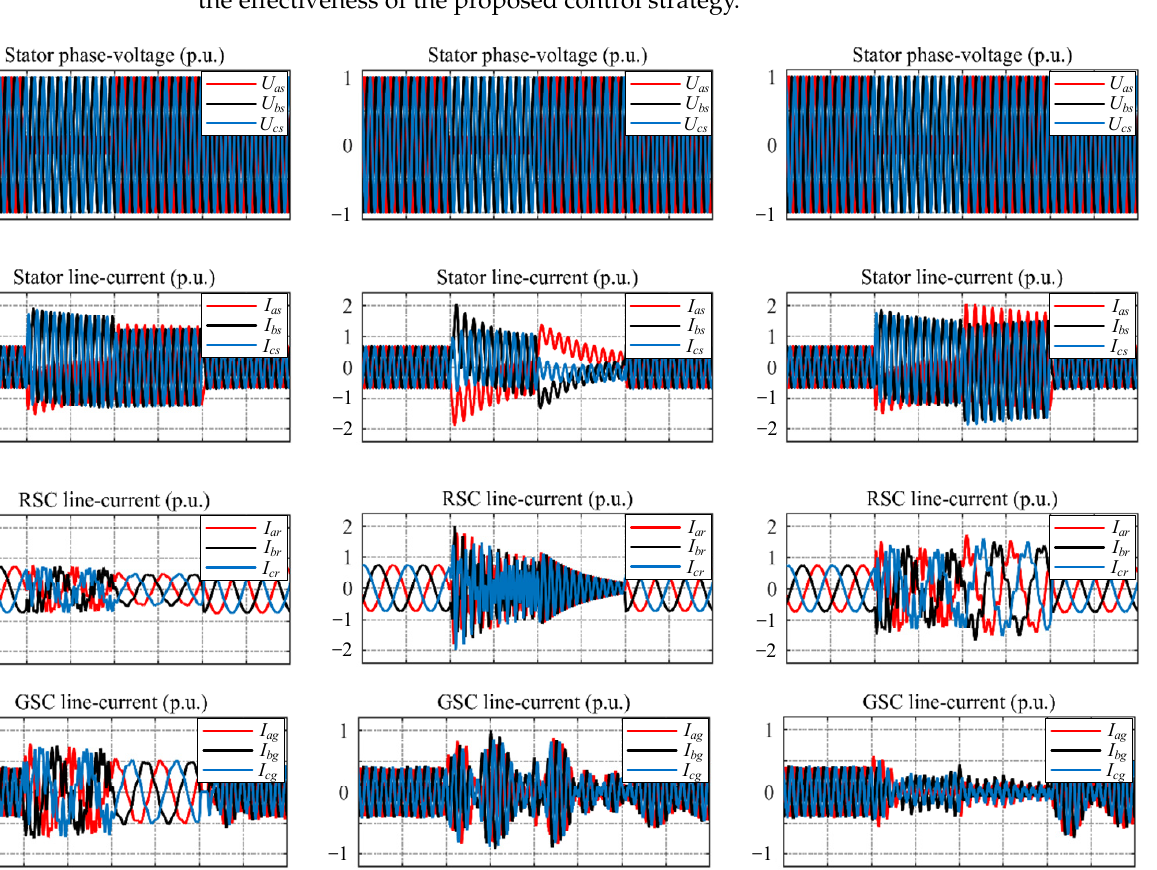
− 1 − 2 Figure 13. Simulation results of single-phase grid voltage sag of 80%. ( a ) DISC. ( b ) Method-1. ( c ) Method-2. 4.3. Assessment of Reactive Power Support Capacity The magnitude of the required reactive current is shown in Figure 1b. This shows that the magnitude of the reactive current is related to the grid sag depth h . When the RSC adopts the stator flux linkage-oriented control, the expression of the stator-side reac- tive power s Q is [19].